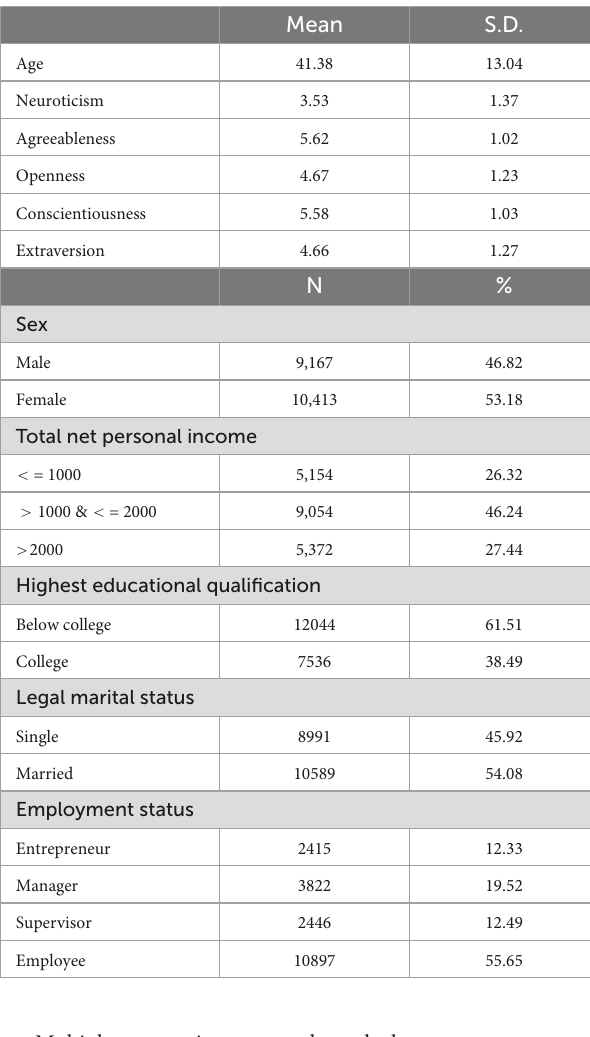
TABLE 1 Descriptive statistics of sociodemographic variables and personality